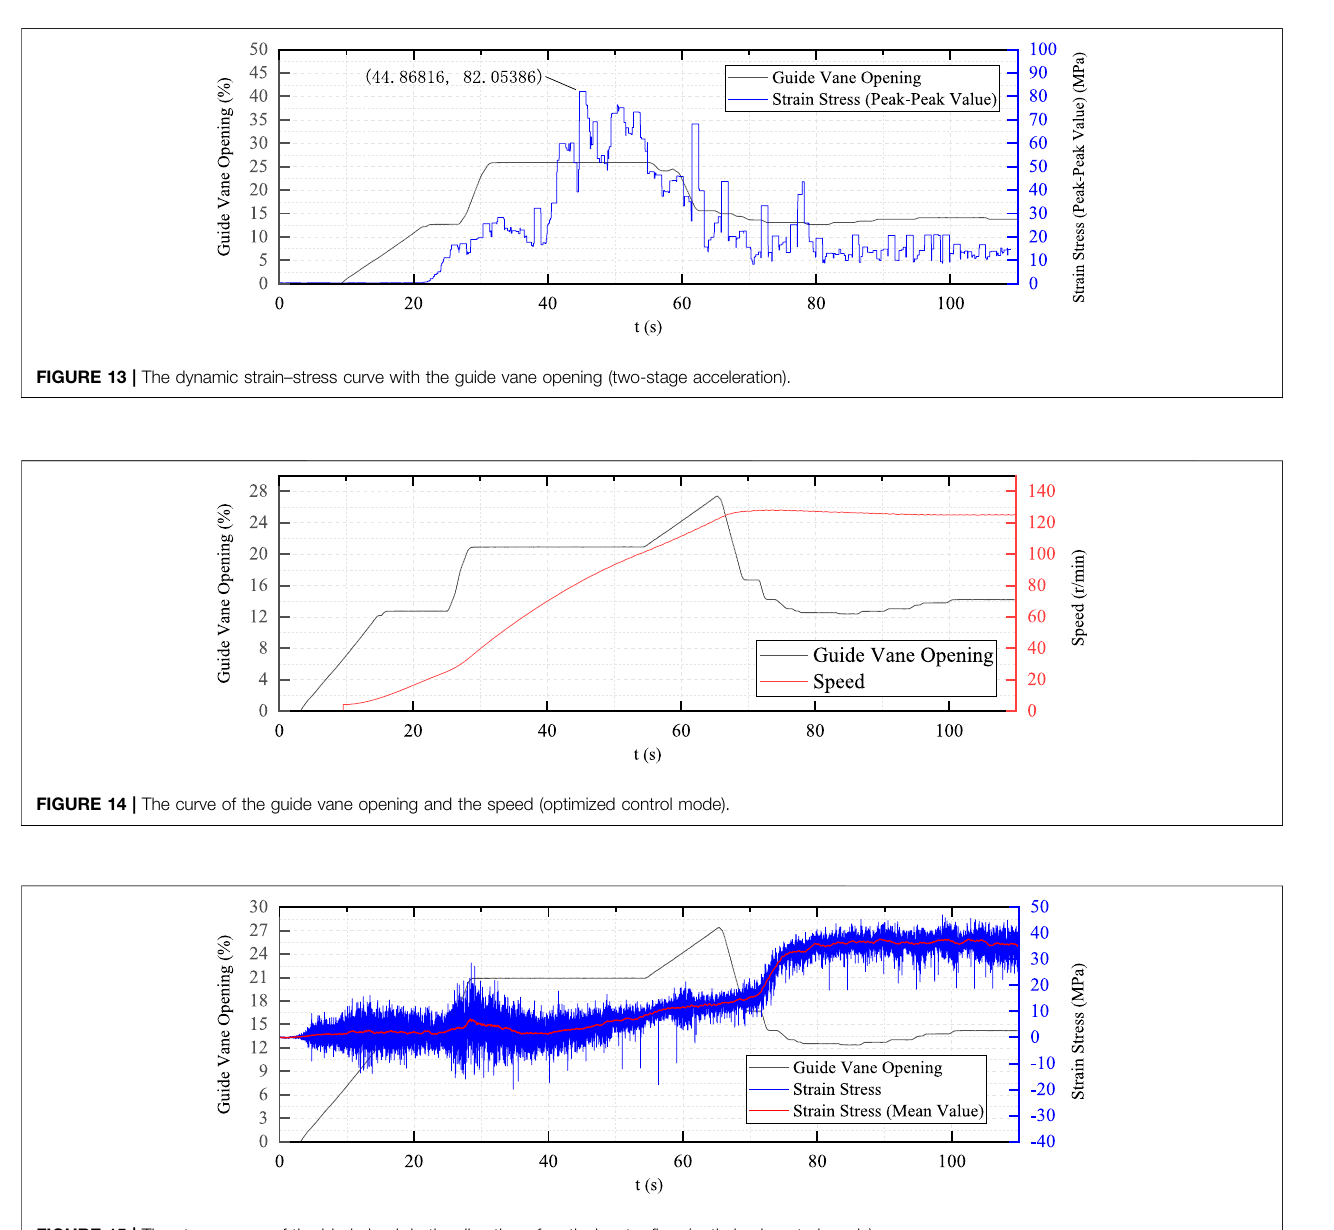
Frontiers in Energy Research |